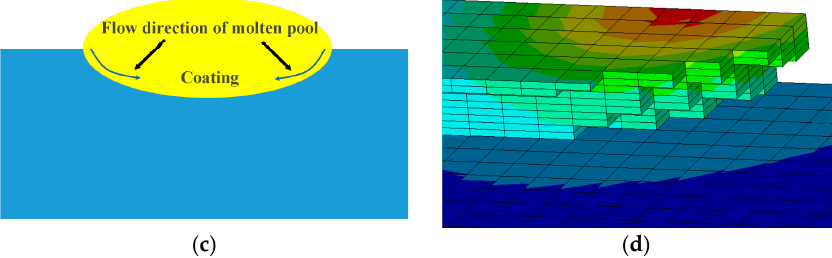
Figure 6. A schematic illustration of the laser cladding process: ( a ) initial stage of laser cladding; ( b ) the molten pool formation and temperature transfer stage; ( c ) the molten pool solidification and coating formation stage; and ( d ) the laser cladding process in the numerical simulation.